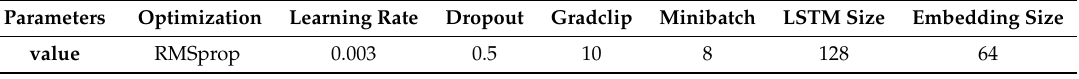
Table 2. Implementation parameters (proposed model, Social LSTM, and Naive